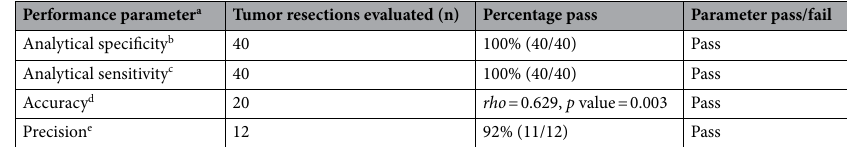
Table 1. DKK1 RNAscope assay validation results. a Details of the pre-defined acceptance criteria are described in the methods. b Signal was predominantly localized to tumor cells. c Signal was detected above